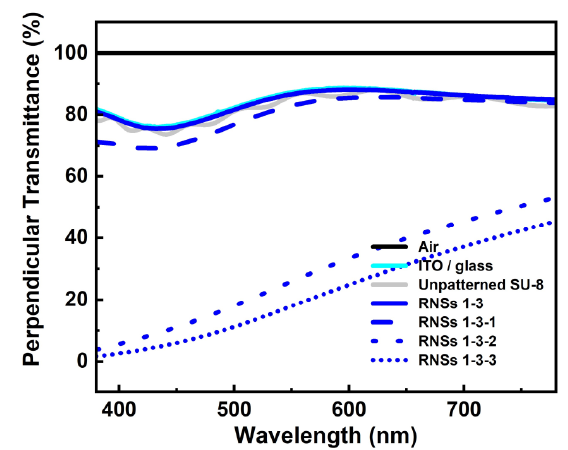
Figure 6. Visible light wavelength perpendicular transmittance of different TiO 2 diluted